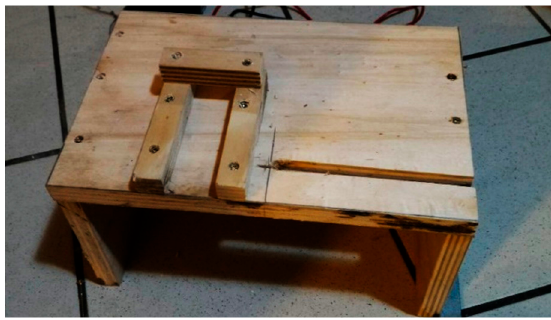
Figure 3. Structure with wooden dinamo housing with recess for metallic